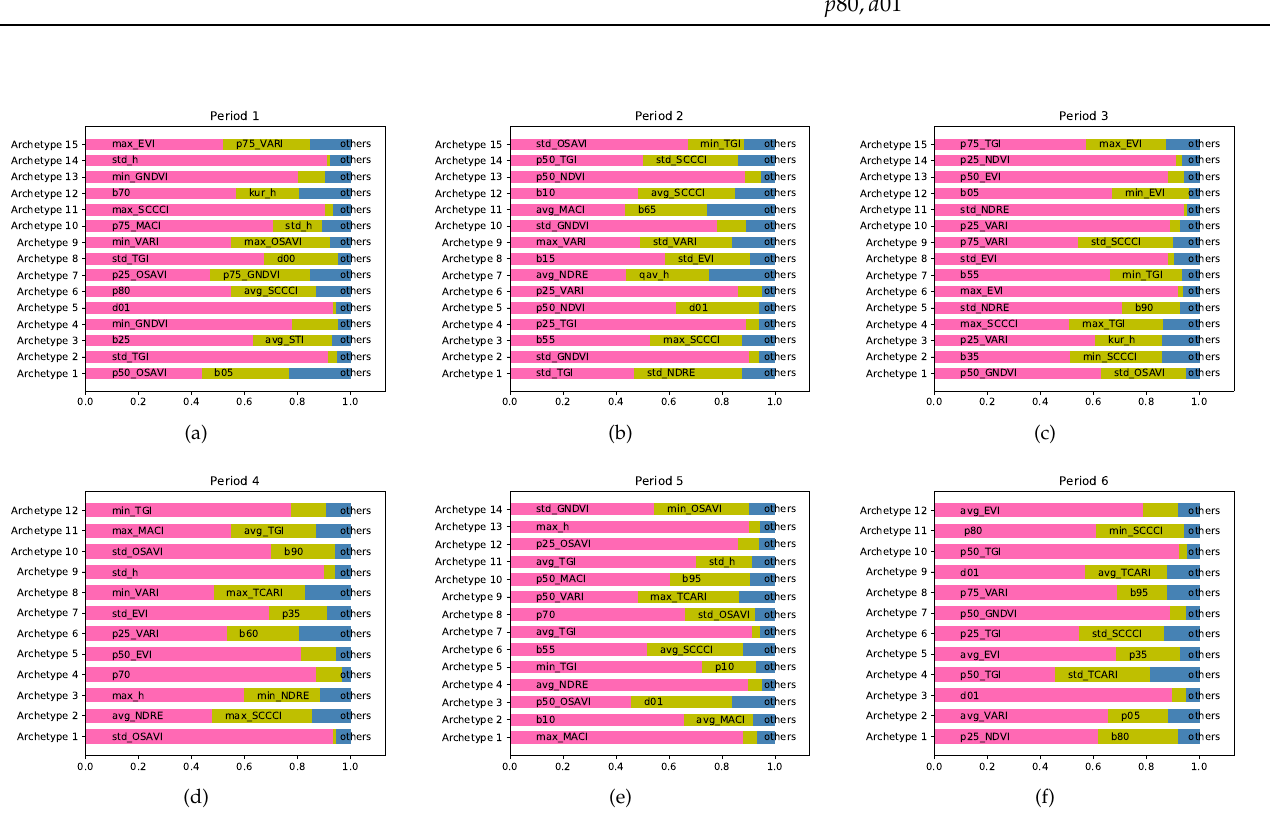
Figure 5. The composition weight of the selected features in the respective archetype, with larger weights implying that the features are more capable of characterizing the extreme properties possessed by the archetype: ( a ) period 1; ( b ) period 2; ( c ) period 3; ( d ) period 4; ( e ) period 5; ( f ) period